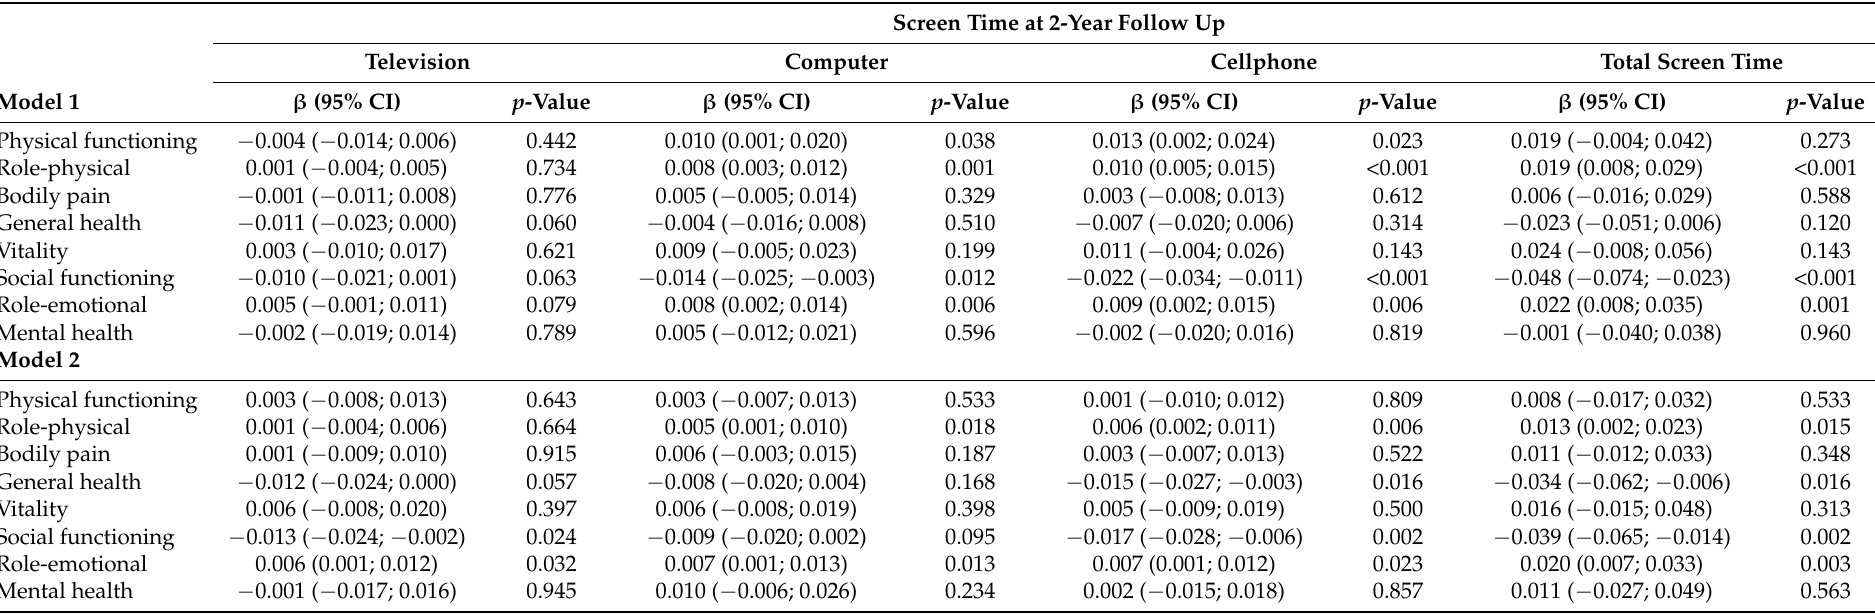
Model 1: Adjusted by baseline values of SF-36 domain score, and baseline values of screen time in the same domain; Model 2: Adjusted by variables of Model 1 for sex, age, socioeconomic score, body mass index, and habitual physical